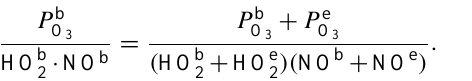
Takes place during a 15min time